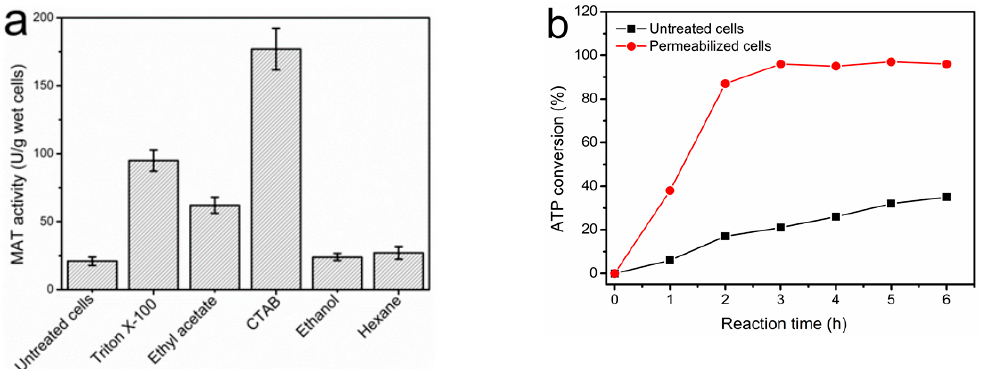
Figure 4. Permeabilization of free whole - cells of E. coli and synthesis of SAM catalyzed by the untreated and permeabilized cells. ( a ) Cell-bound I303V MAT activity for E. coli cells permeabilized with different detergents (0.1% w / v ) or organic solvents. Treatment was carried out for 30 min with 10 mL/g wet cell weight; ( b ) Conversion rate of the ATP substrate catalyzed by untreated and permeabilized E. coli cells as a function of time. Reactions were performed in a 100-mL volume and included: 40 mM ATP, 50 mM L -methionine ( L -Met), 50 mM K 2 SO 4 , 100 mM MgSO 4 , 0.3 M sodium p -toluenesulfonate, 100 mM Tris-HCl, and 1 g of cells at 37 °C, pH 7.0. The consumption of ATP and the production of SAM were determined by HPLC analysis, and the MAT activity was calculated according to the production of SAM.